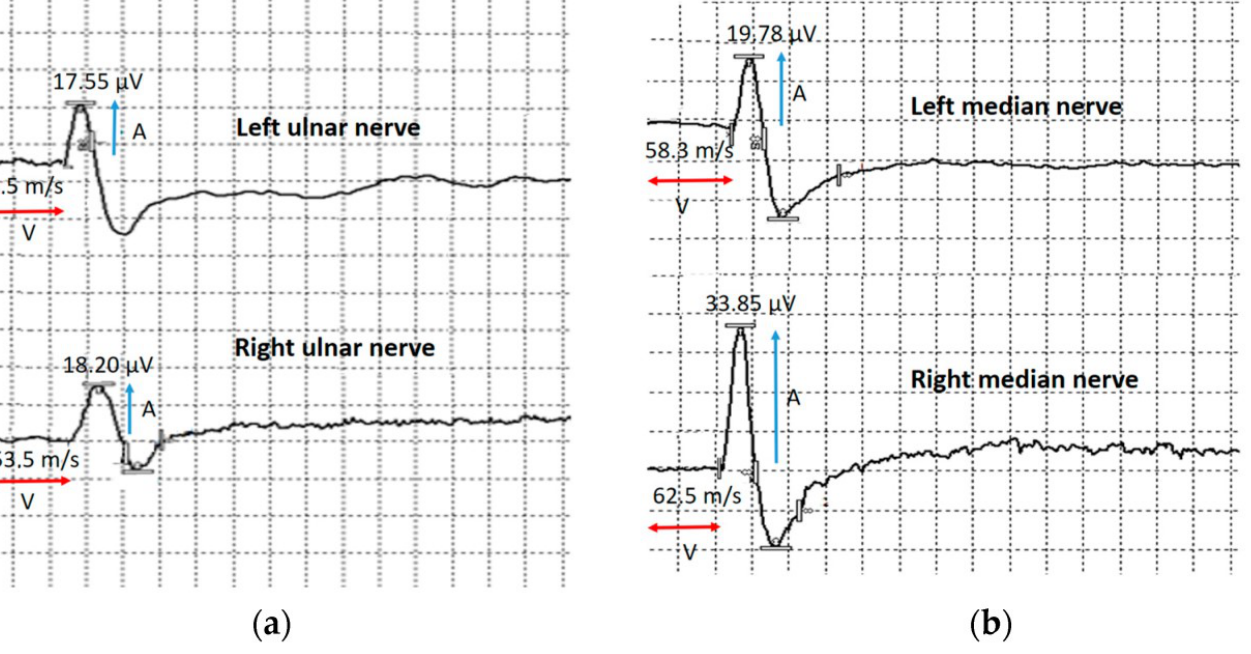
Figure 9. Sensory conduction velocity of the upper extremities nerves. ( a ) Sensory conduction velocity (V) and sensory nerve action potential amplitude of the left and right ulnar nerves. ( b ) Sensory conduction velocity (V) and sensory nerve action potential amplitude (A) of the left and right median nerves. Blue arrows show compound muscle action potential amplitude and red arrows show conduction velocity.